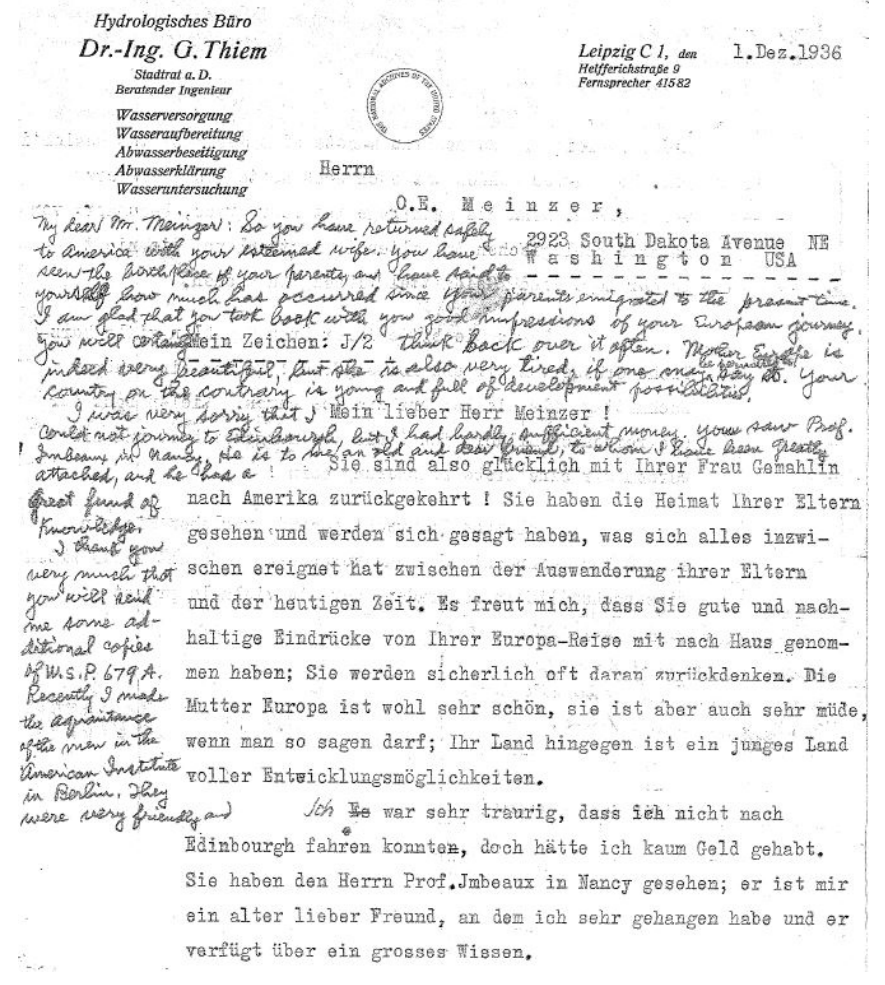
Figure 11. The first page of a typewritten letter by Günther Thiem, with a handwritten translation by Oscar Edward Meinzer (USGS, 1936– 1940; Thiem to Meinzer, 1 December 1936).